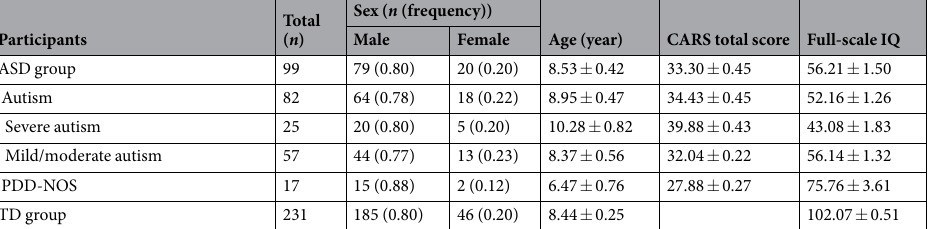
Table 5. Participant characteristics. The values are expressed in mean ± SEM. ASD, autistic